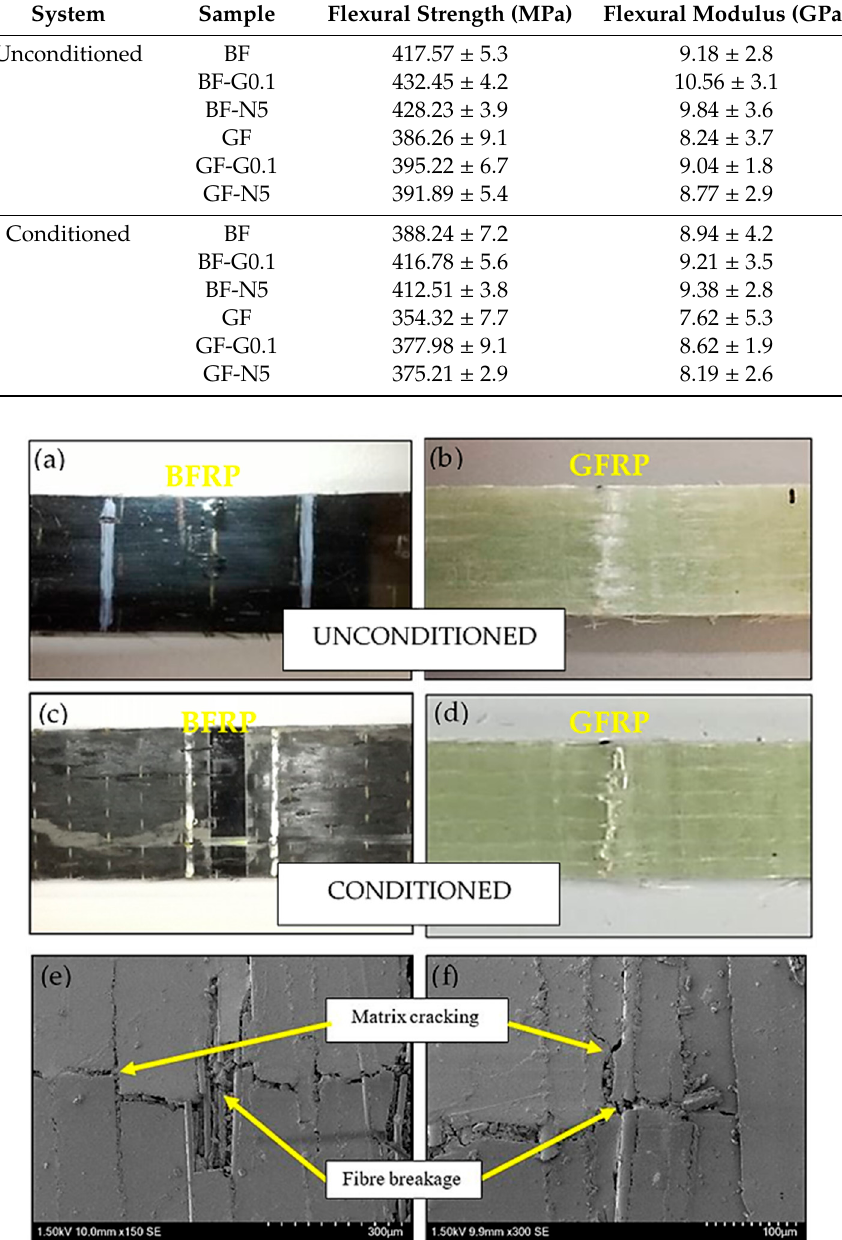
Table 3. The variation in flexural properties of BFRP and GFRP composites under accelerated weather conditions.